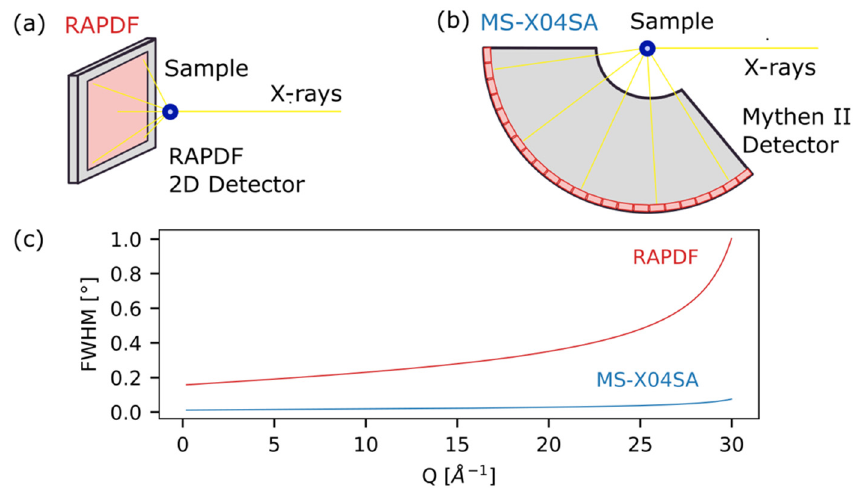
Figure 2. Schematics of the experimental setups employed for ( a ) RAPDF acquisition mode for high- Q X-ray total scattering data (PDF analysis) and ( b ) high angular resolution datasets, ensured by the implementation of a position-sensitive 1D array detector, employed for reciprocal space data analysis. ( c ) Full width at half maximum (FWHM) vs. Q for the two experimental setups reported in ( a ) (IRF: ha = 0.07807, hb = 0.20620, and hc = 0.07882; η = 0.15729) and ( b ) (IRF: ha = 0.01130, hb = 0.01990, and hc = 0.00010; η = 0.35903), showing the poorer angular resolution for the RAPDF acquisition mode and the angle-dependence of both instrumental resolution functions.